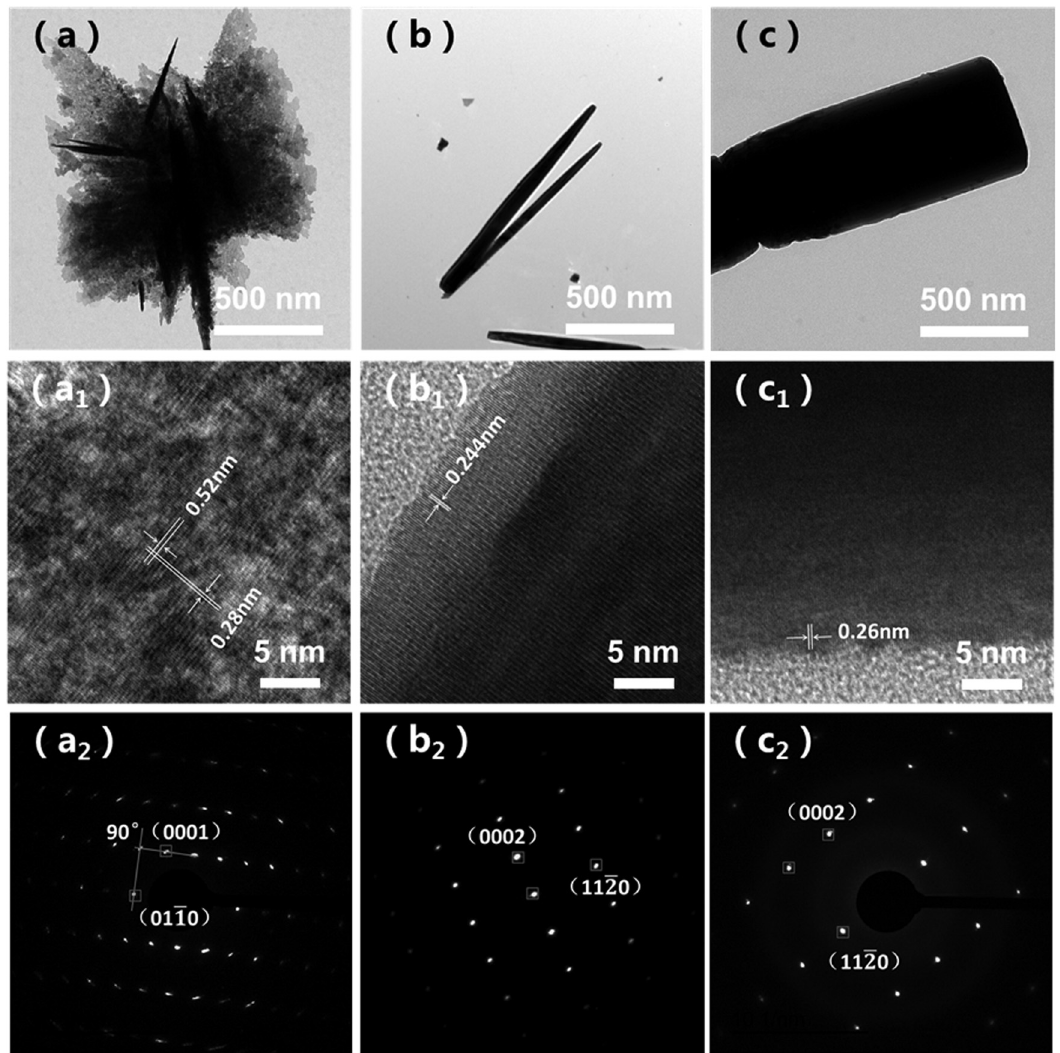
Figure 5: TEM and HRTEM images of samples, ( a, a 1 , and a 2 ) fl ower - like ZnO, ( b, b 1 , and b 2 ) urchin - like ZnO, and ( c, c 1 , and c 2 ) rod - like